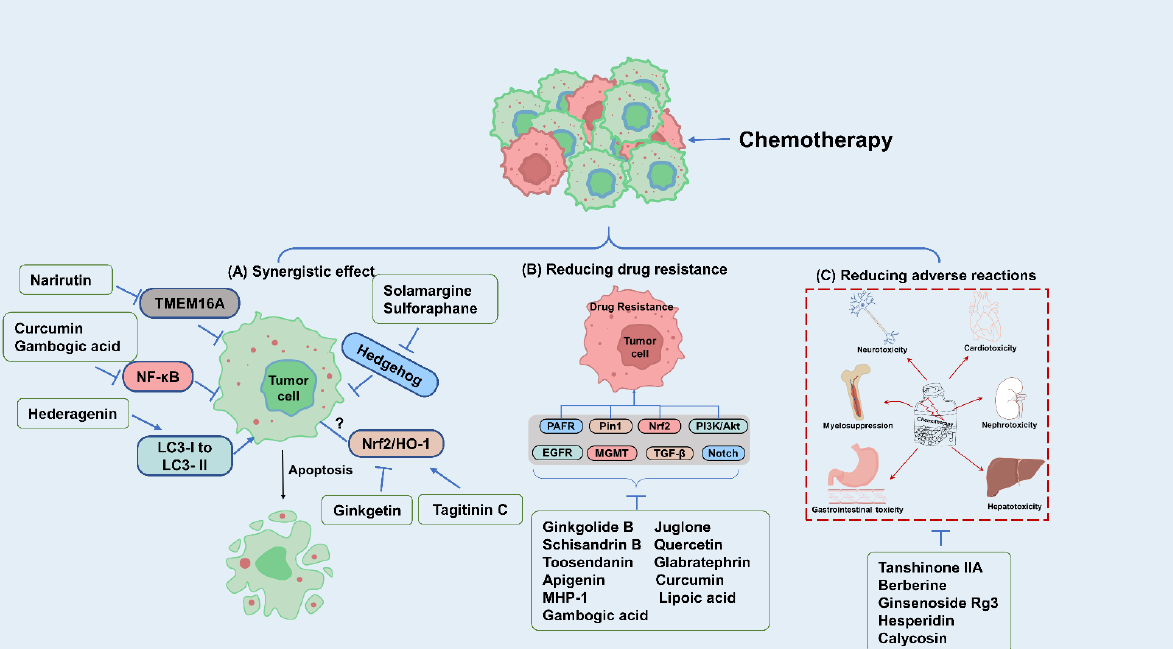
Figure 1. Natural compounds in combination with chemotherapeutic agents enhance therapeutic efficacy by synergizing, reducing tumor resistance, and mitigating adverse effects of chemotherapy.